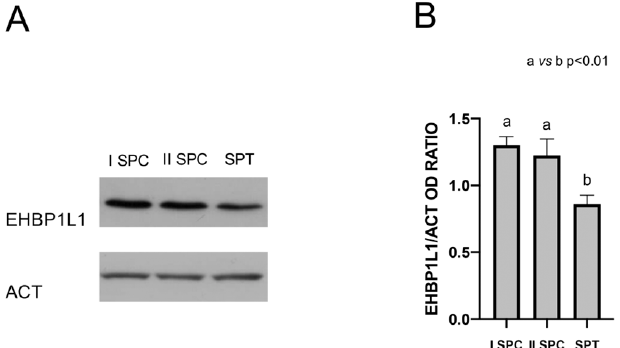
the insets, where they represent 10 µ m. Arrow: I SPC; dotted arrow: rSPT; striped arrow: eSPT.